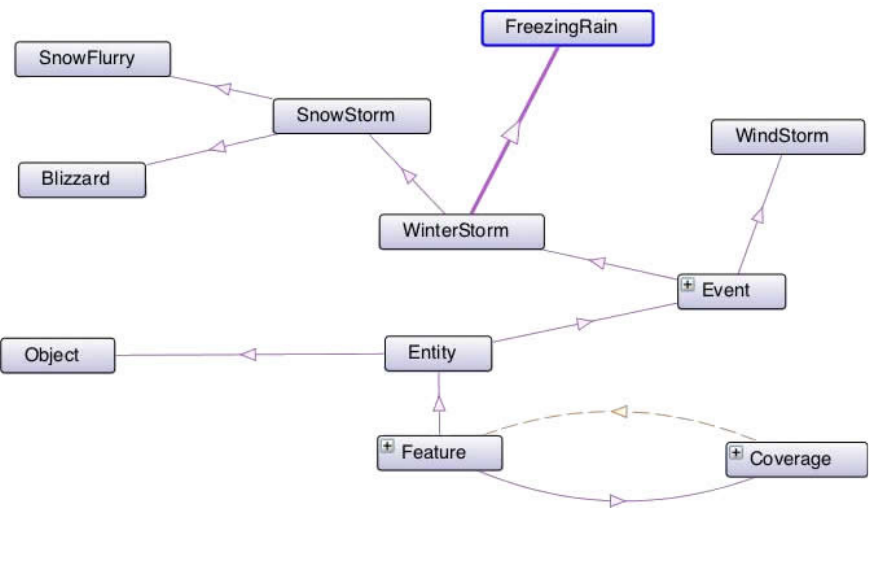
Figure 3. Snippet of sensor-observation